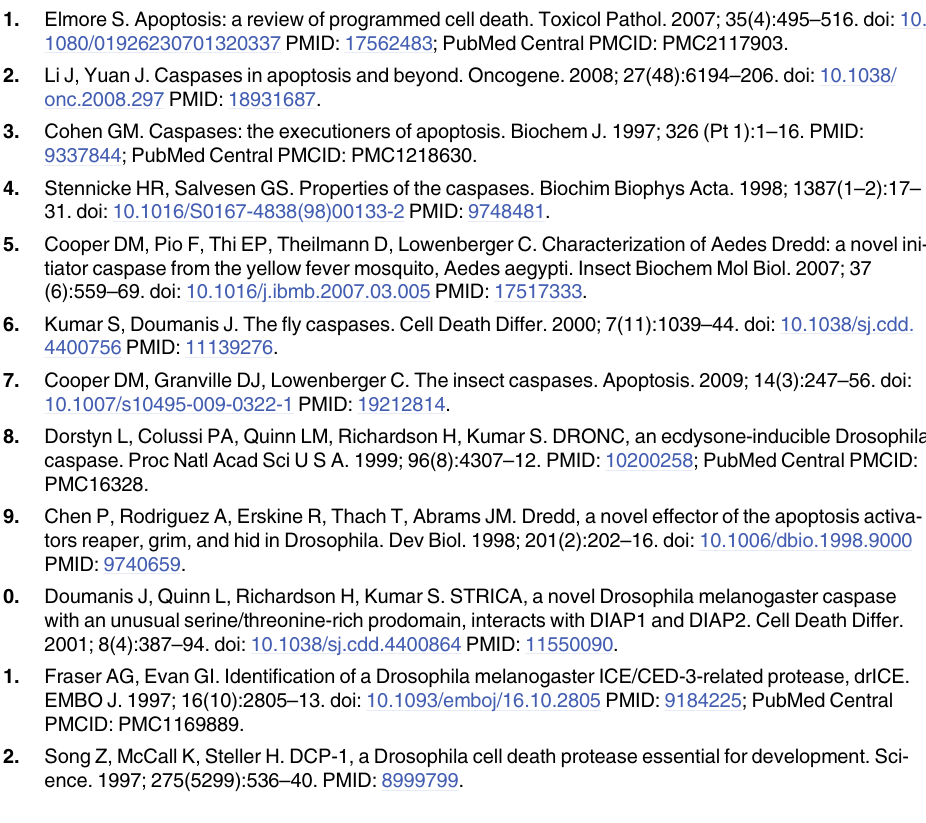
S1 Table. Primers used for RACE. S2 Table. Primers used for mutagenesis. S3 Table. Primers used for dsRNA synthesis. S4 Table. Sequences used for alignments and phylogenetic